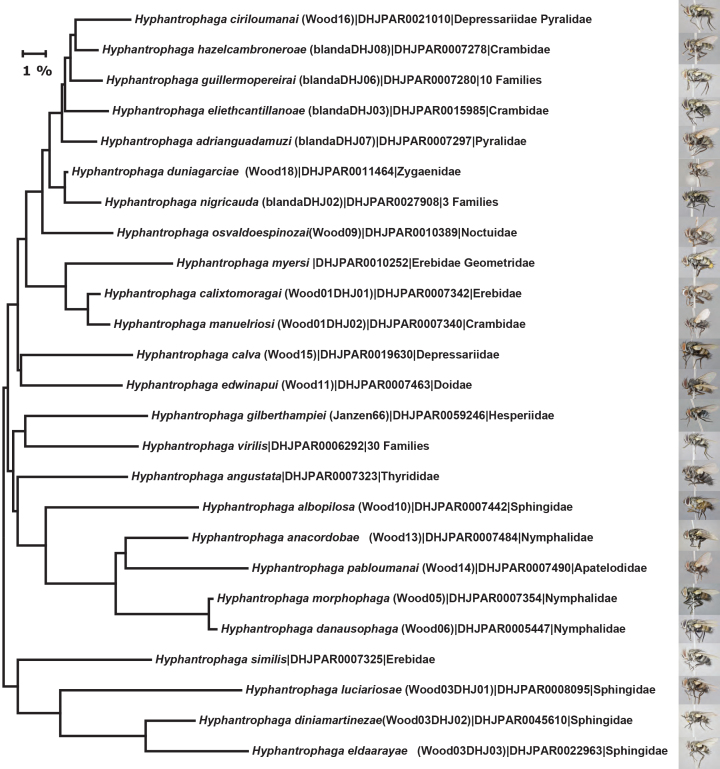
CO1 NJ tree for the Hyphantrophaga spp. of ACG (Costa Rica). Tip labels are the species names [(older interim name)|sample accession|host family(ies)].